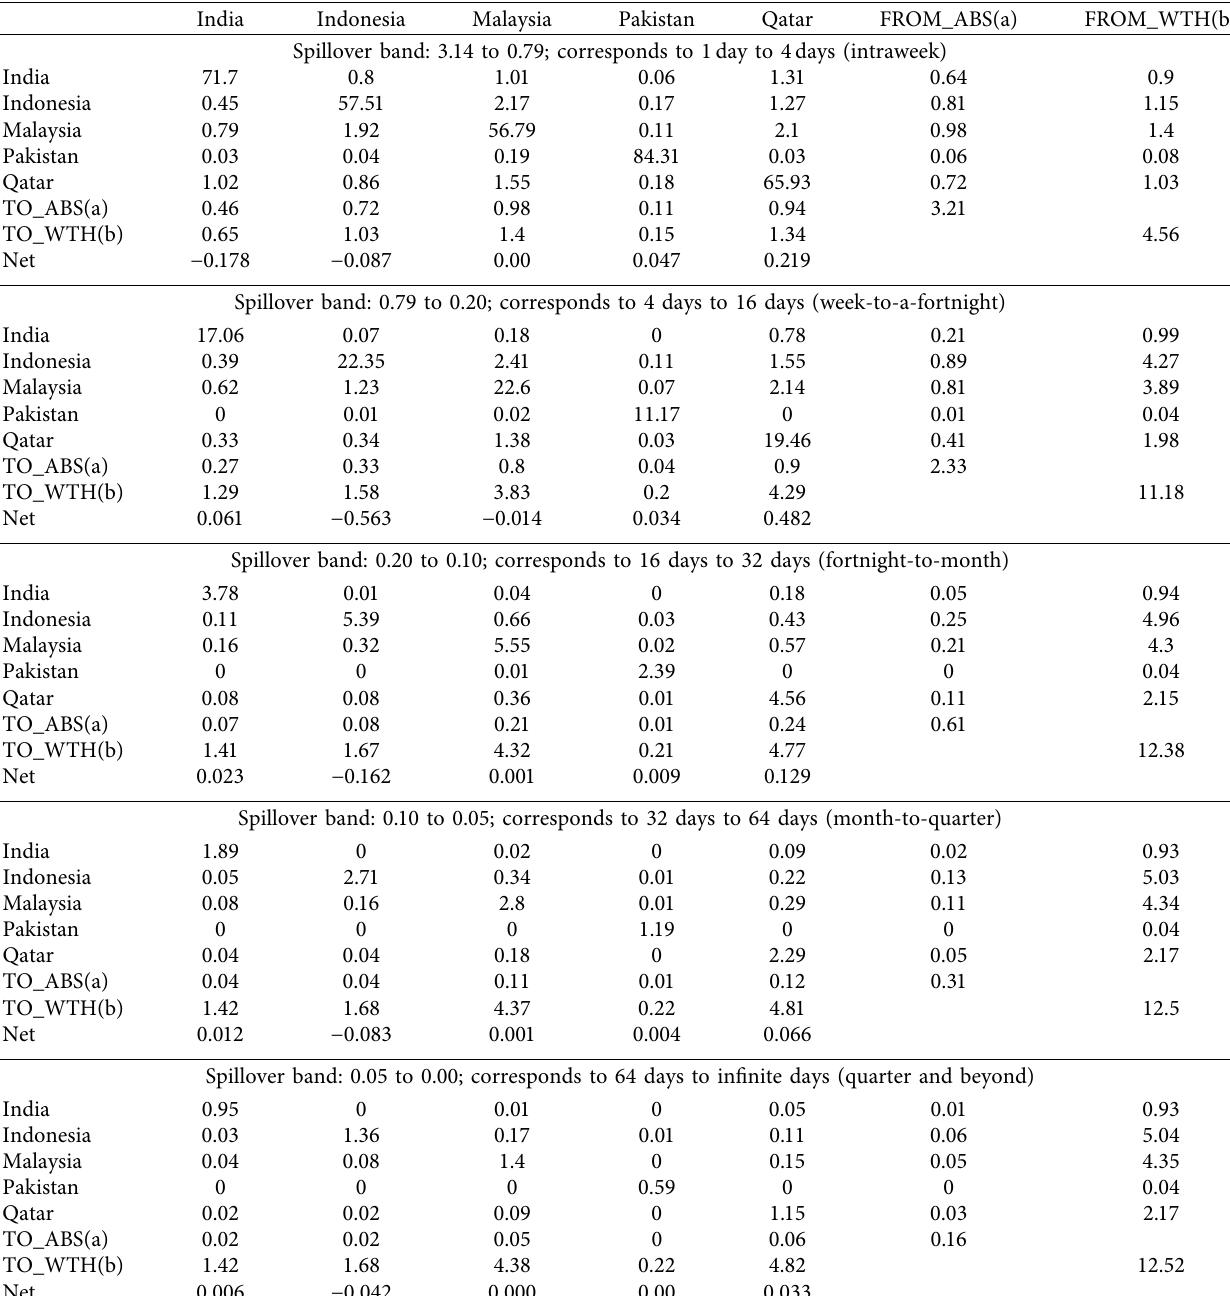
Table 4: Total and Net spillover indices across frequency bands for Islamic